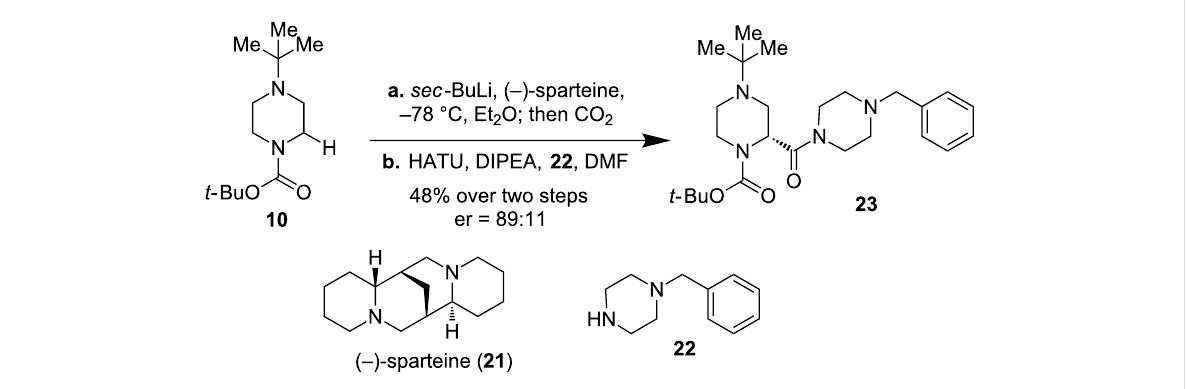
Figure 6: The first enantioselective α -lithiation of N -Boc-piperazines by McDermott et al. in 2008 [41].